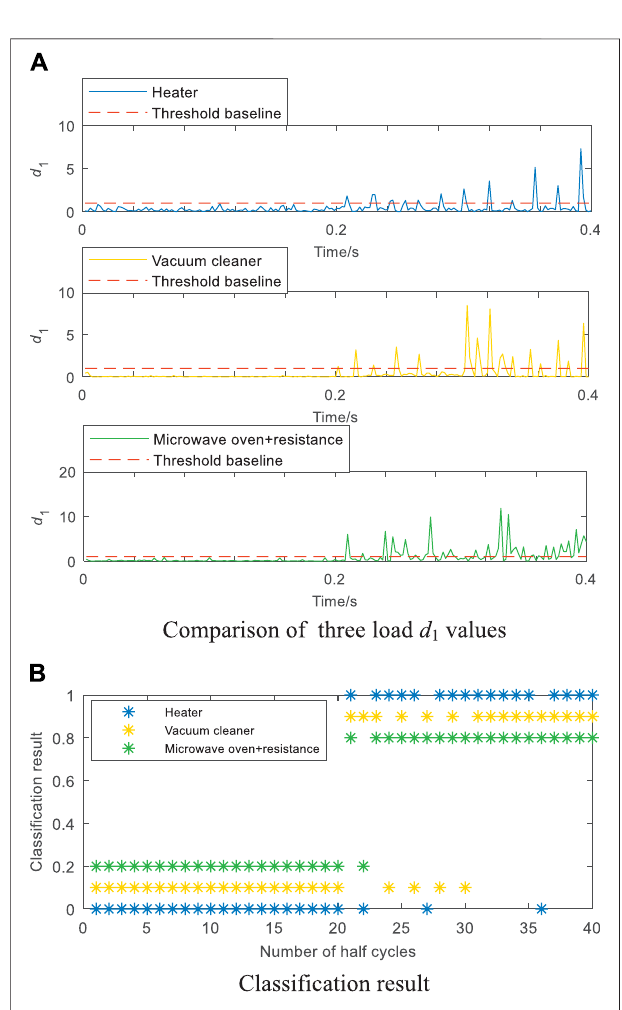
FIGURE 9 | Effect of the current cycle similarity derivation method on three kinds of load detection. (A) Comparison of three load d 1 values. (B) Classi fi cation